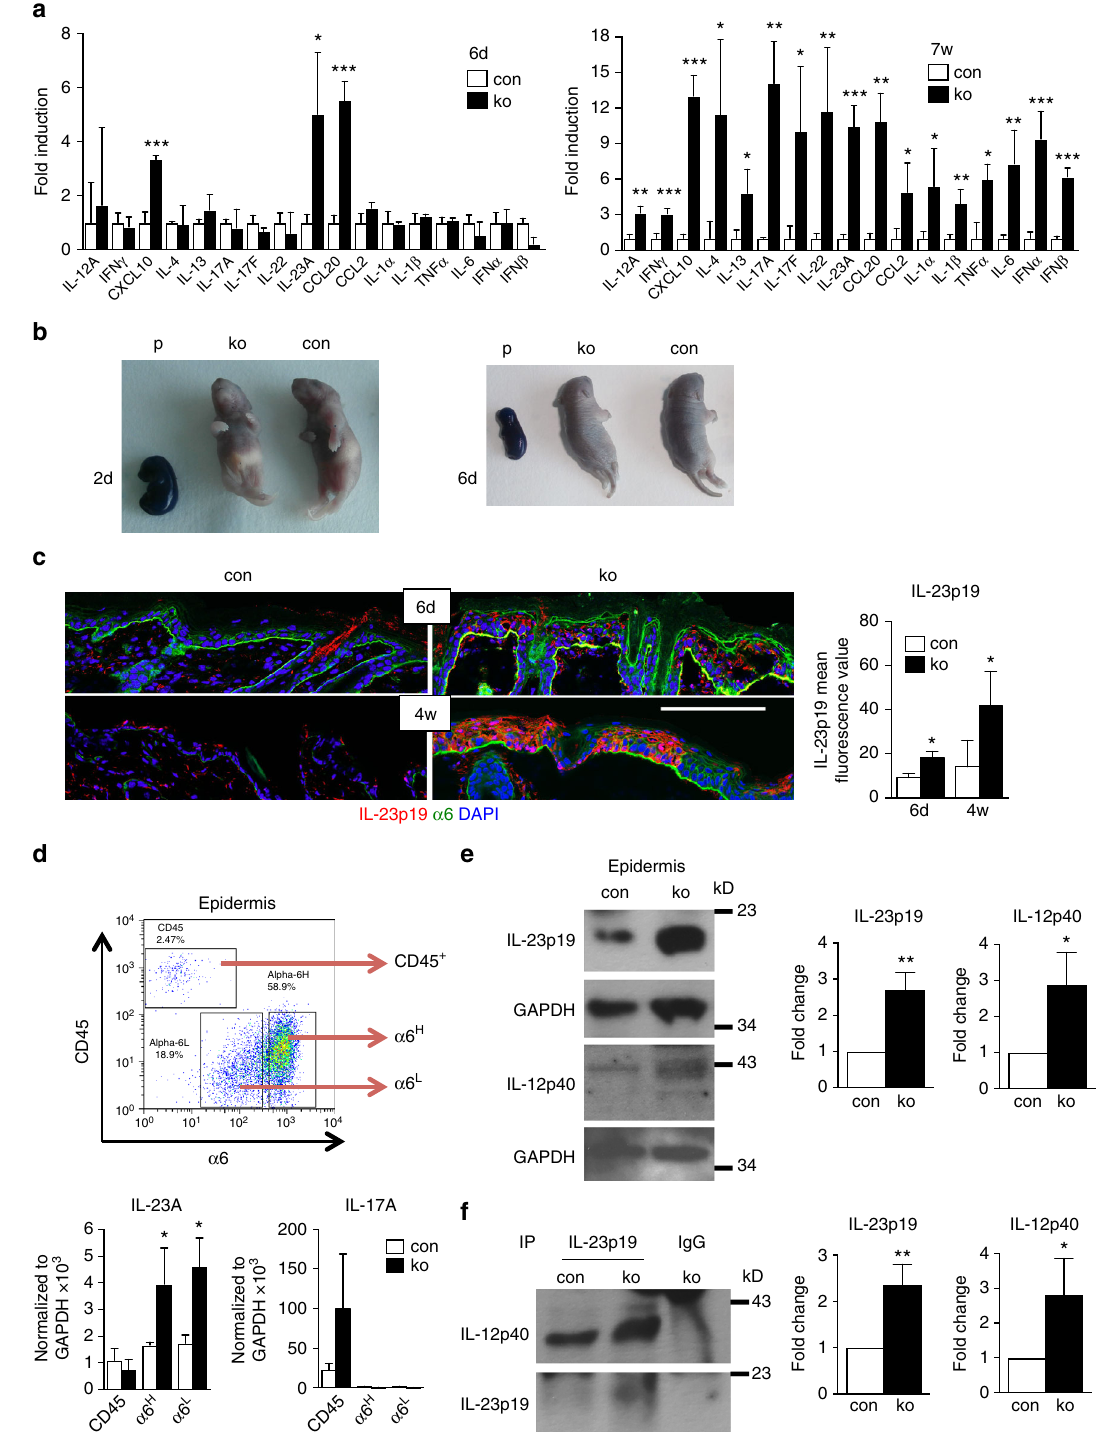
Fig. 3 Increased cytokine expression in N-WASP- null skin. a qRT-PCR analysis of indicated genes from back skin RNA of con and ko at indicated ages ( n > = 3/3, two-tailed unpaired t -test). All normalized to GAPDH. b Representative toluidine blue staining for barrier defect in con and ko mice at indicated ages (P: E15.5 embryos used as positive controls; 2 days (2d) n : 6/5, 6 days(6d) n : 4/5, 3 independent experiments). c Representative immuno fl uorescence staining and quanti fi cation of IL-23p19 of con and ko back skin at indicated ages ( n : 3/3, two-tailed paired t -test). Scale bar: 100 µ m. d Representative sorting strategy of CD45 + , α 6 H , and α 6 L cells from con and ko epidermal cells and qRT-PCR analysis of IL-23A and IL-17A expression in sorted cells ( n : 3/ 3, mean ± SD, two-tailed unpaired t -test, 3 independent sortings). e Representative immunoblots and quanti fi cation of indicated proteins from epidermal lysates of 7 – 8-week old con and ko mice ( n : 4/4, mean ± SD, two-tailed unpaired t- test). f Representative immunoblots and quanti fi cation of indicated proteins of co-precipitations of IL-23p19 with IL-12p40 from epidermal lysates of 7 – 8-week-old con and ko mice ( n : 4/4, mean ± SD, two-tailed unpaired t - test; * p ≤ 0.05; ** p ≤ 0.01; *** p ≤